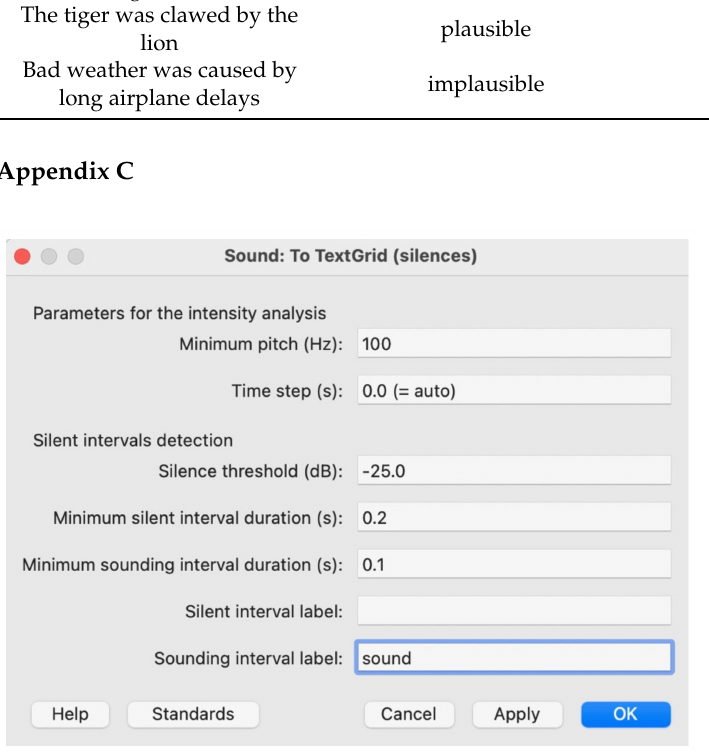
Figure A1. The Praat settings for the semi-automated sound-pause